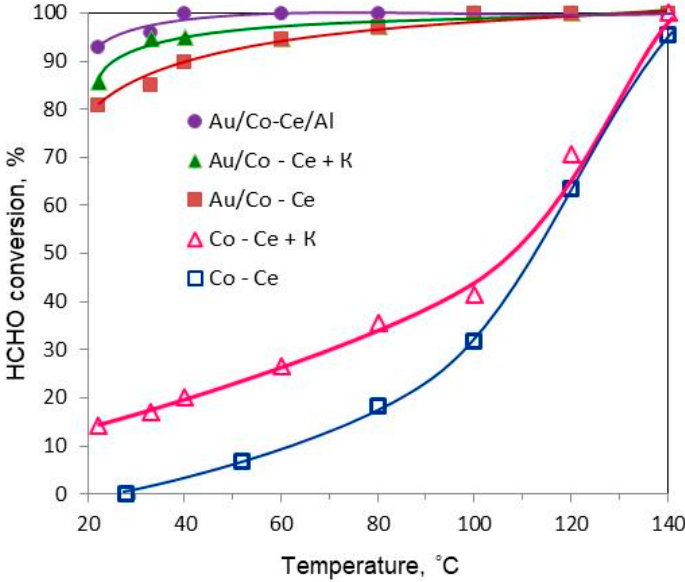
Figure 1. Temperature dependence of HCHO conversion over the studied samples.